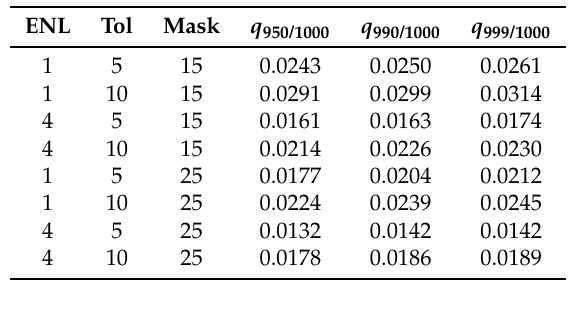
Table 3. Critical values of